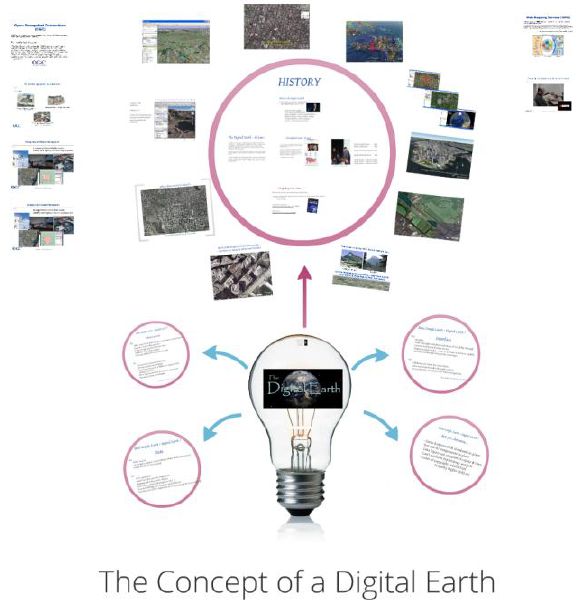
Figure 3 Prezi screenshot of introductory